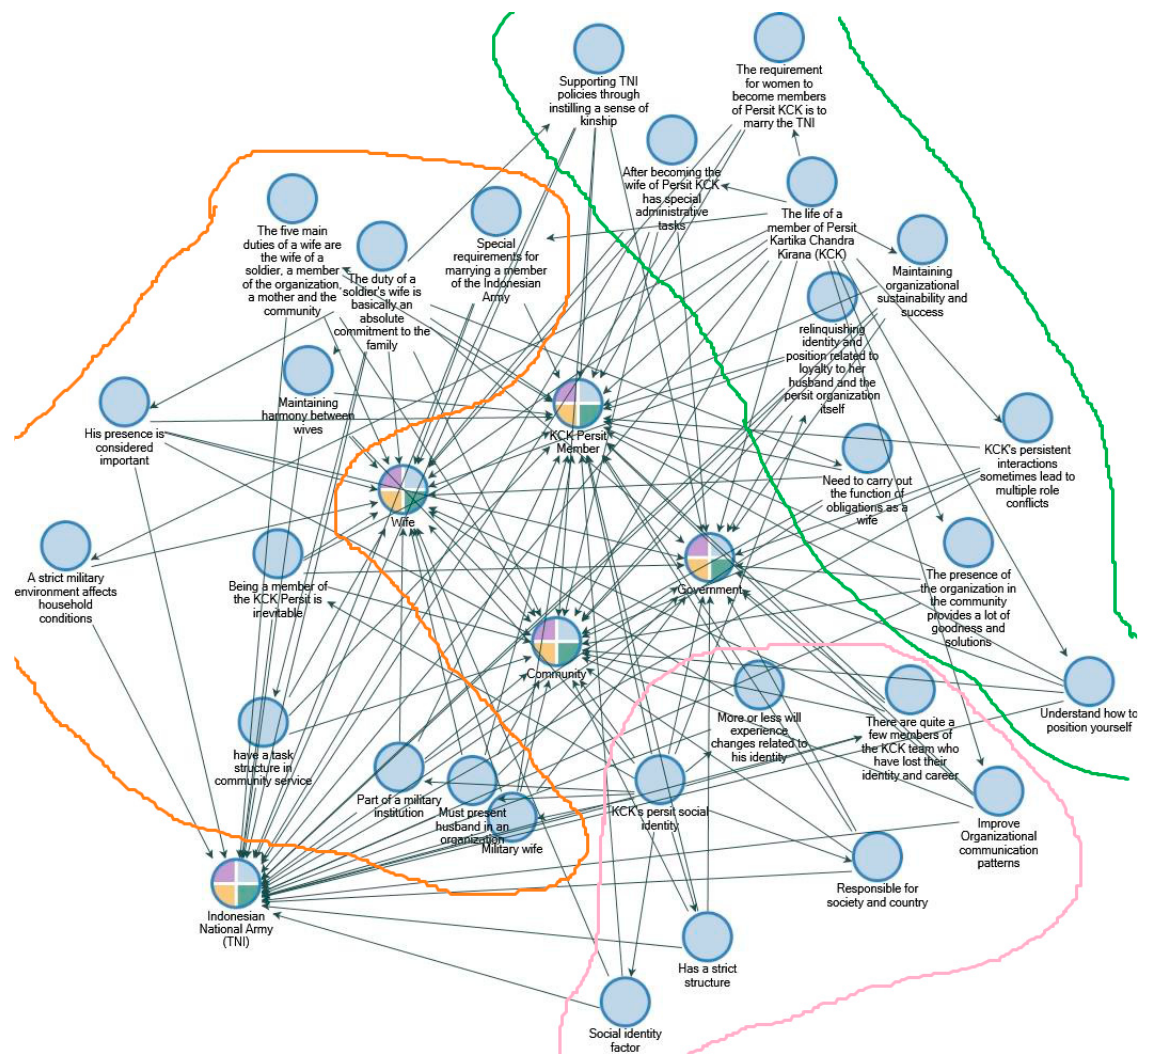
Figure 4. Information network analysis of interaction patterns and communication processes in the Persit-KCK organization. Source: processed by the author via Nvivo 12 Pro , 2022